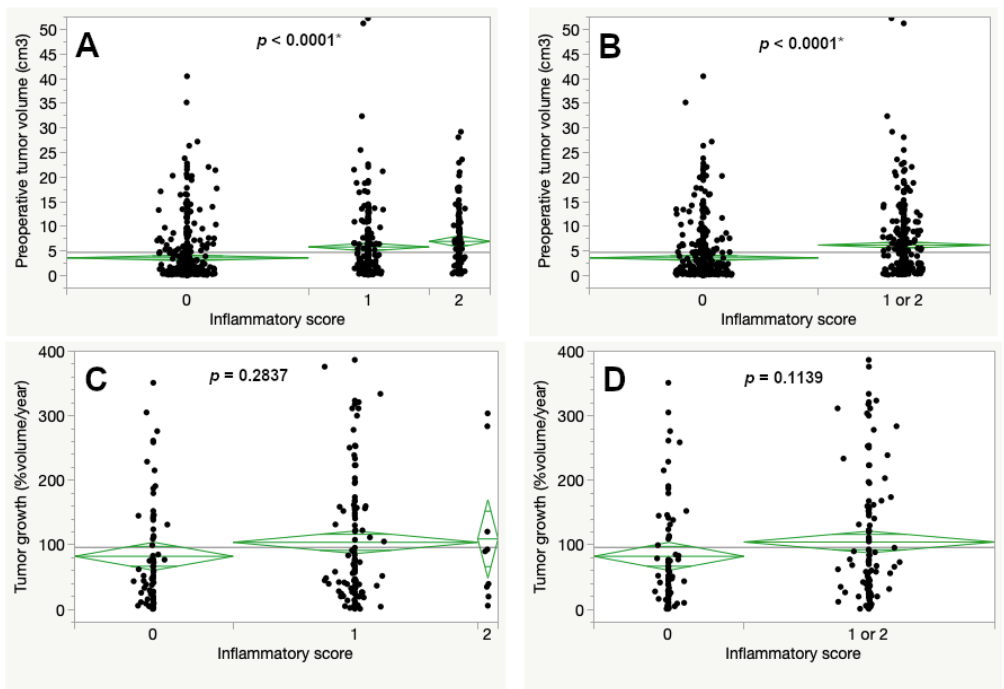
Figure 5. Preoperative tumor volume ( A , B ) and percentual volumetric tumor growth ( C , D ) according to the inflammatory score (ANOVA; an asterisk (*) marks statistically significant results).